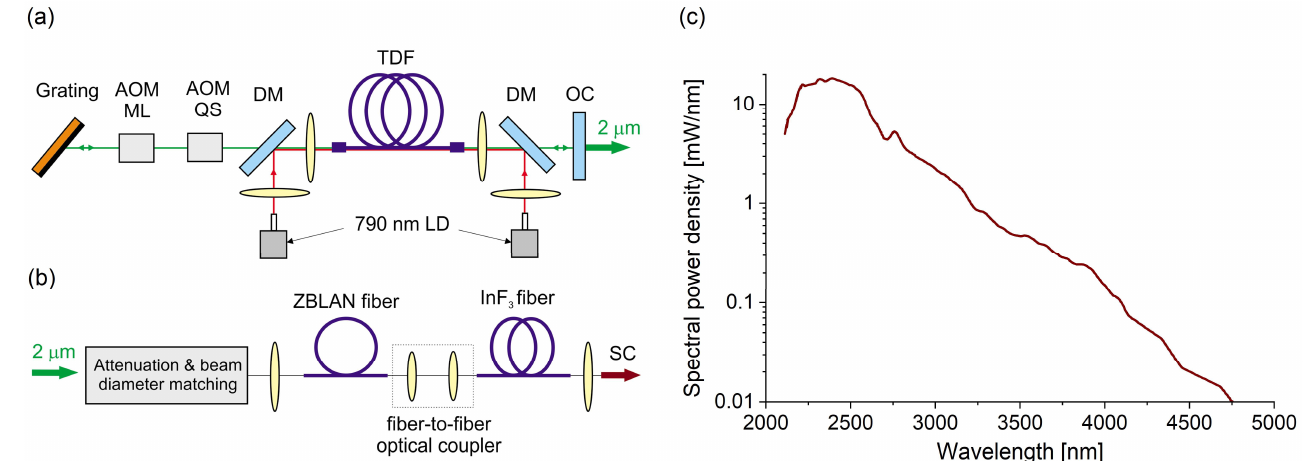
Figure 12. Schematic of the setup of the thulium-doped fiber laser ( a ); experimental setup used to generate SC radiation ( b ) and SC spectrum for an output power of 7 W ( c ). AOM—acousto-optic modulator, ML—mode-locker; QS—Q-switch, TDF—thulium-doped fiber, OC—output coupler, LD—laser diode, DM—dichroic mirror. Adopted with permission from [122]. Copyright 2020, Optica Publishing Group.